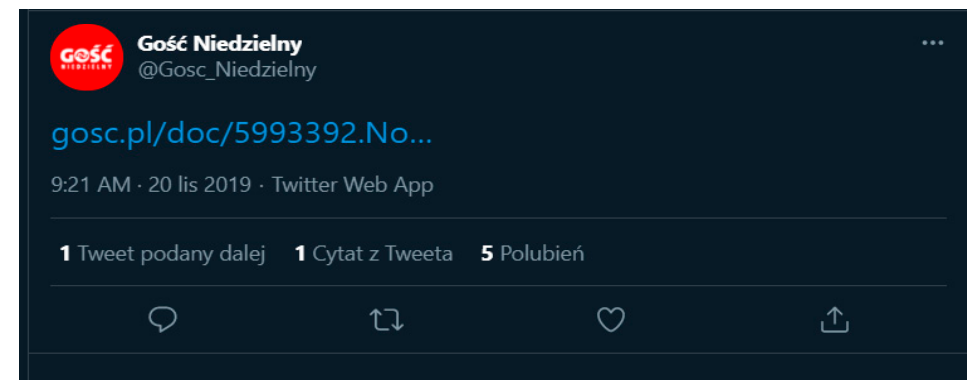
Figure 5. A self-promotional tweet by Go ść Niedzielny , 20.11.2019. Source: Twitter/screenshot.